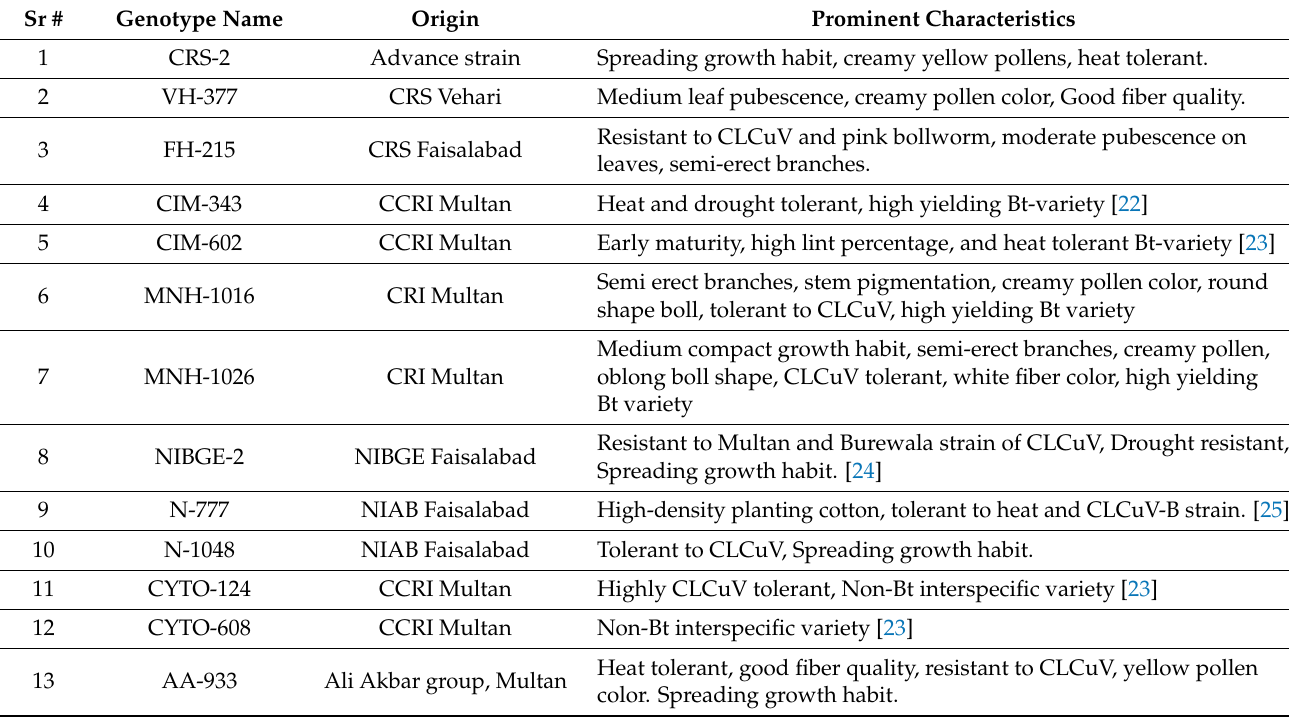
Table 1. List of 13 cotton genotypes of G. hirsutum L. evaluated for heat